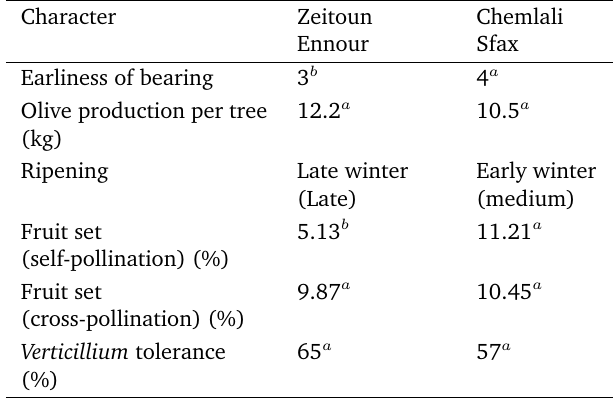
Table 2. Description of the main agronomic characteristics of the new olive cultivar compared with ‘Chemlali